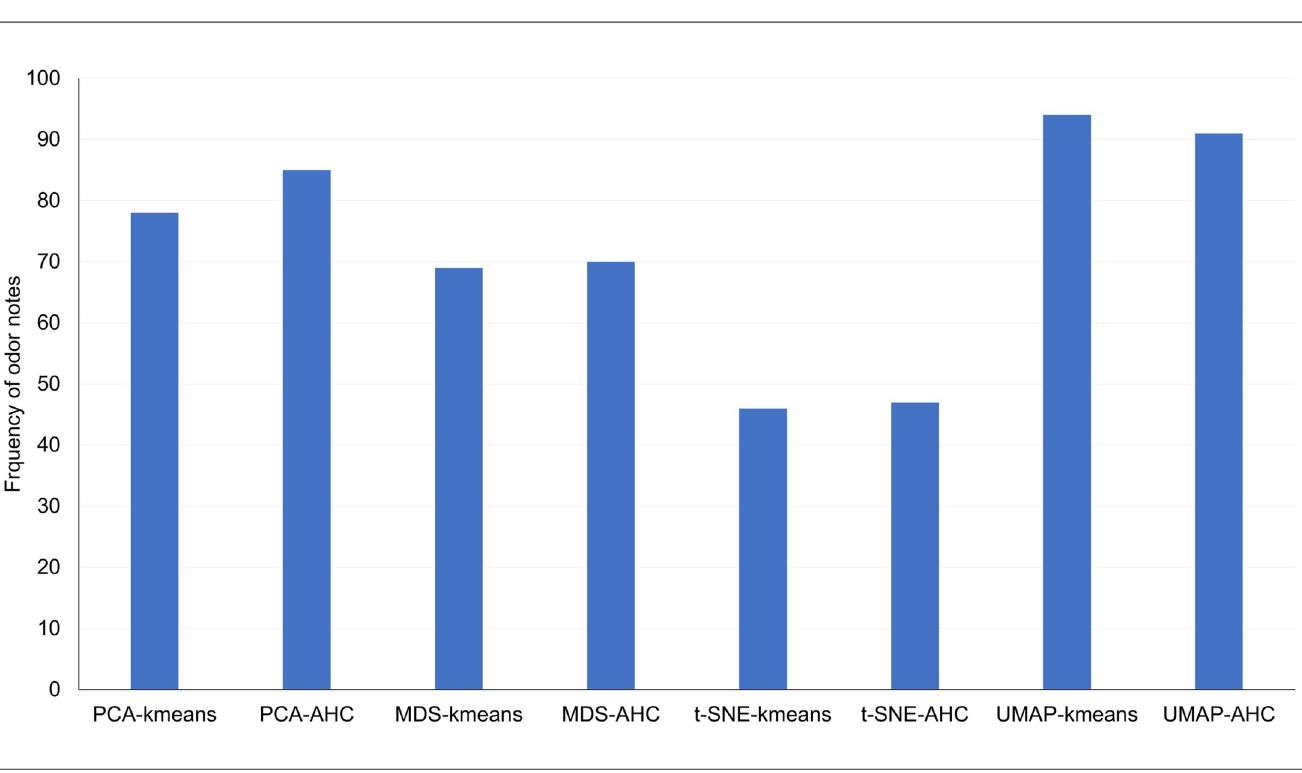
Fig 5. Histogram of the number of odor notes whose %ON is greater than 50 for each technique. https://doi.org/10.1371/journal.pone.0252486.g005 PLOS ONE | https://doi.org/10.1371/journal.pone.0252486 May 28,